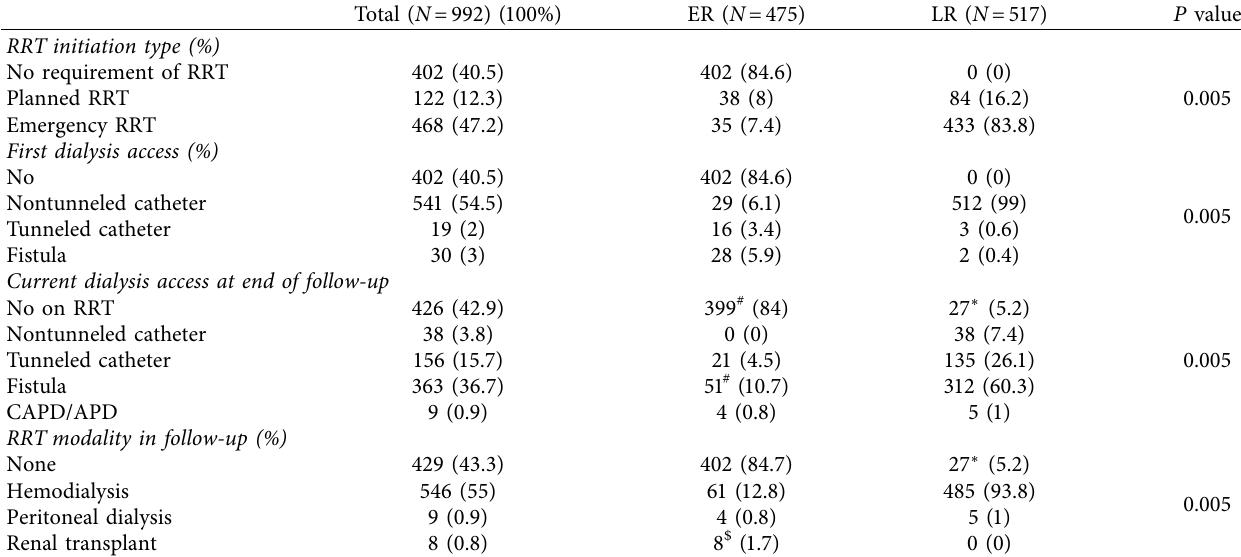
Table 2: Outcome-related characteristics with reference to referral pattern.